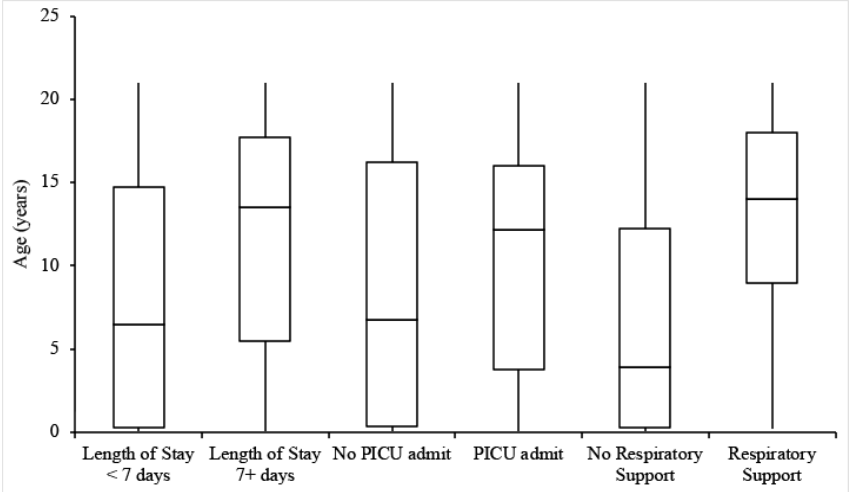
Figure 1. Box-and-whisker plots for the ages of patients experiencing each outcome of interest.